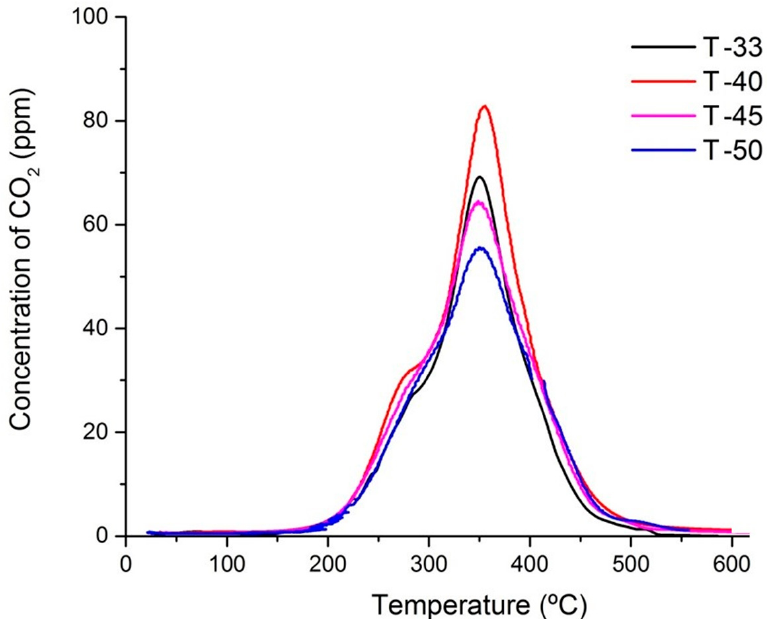
Figure 5. Temperature programmed oxidation of spent catalysts with a mixture of 20 vol.% O 2 in He. Heating rate: 5 K min − 1 .